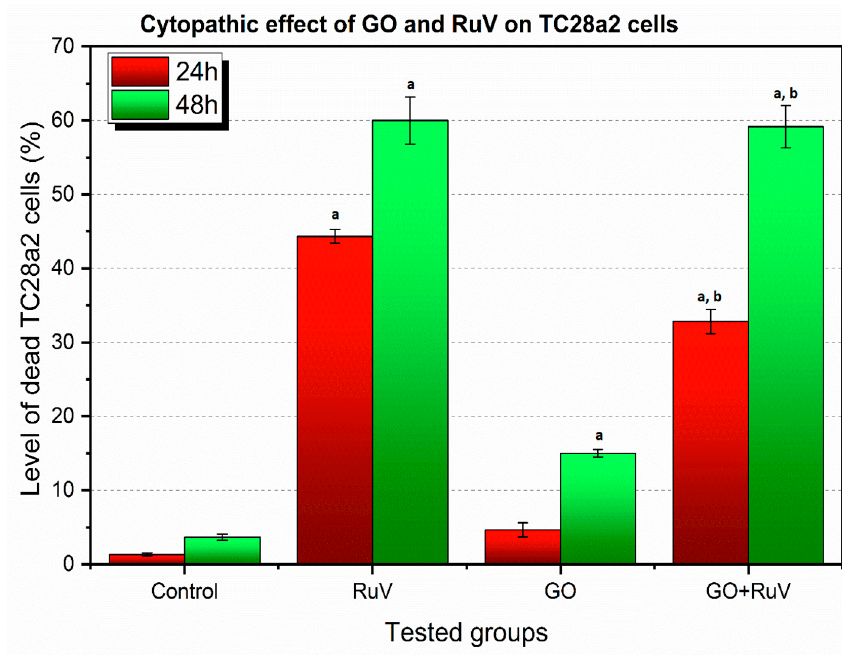
Figure 6. Percentage of cytopathic effect TC28a2 cell line. RuV—cells infected with RuV, GO—cells with graphene added, GO + RuV—cells infected with RuV and with graphene added. Statistical significance at p < 0.05—a: when compared to control group; b: when compared to RuV group. with RuV between 24 h and 48 h of incubation, but the percentage of dead cells after 48 h